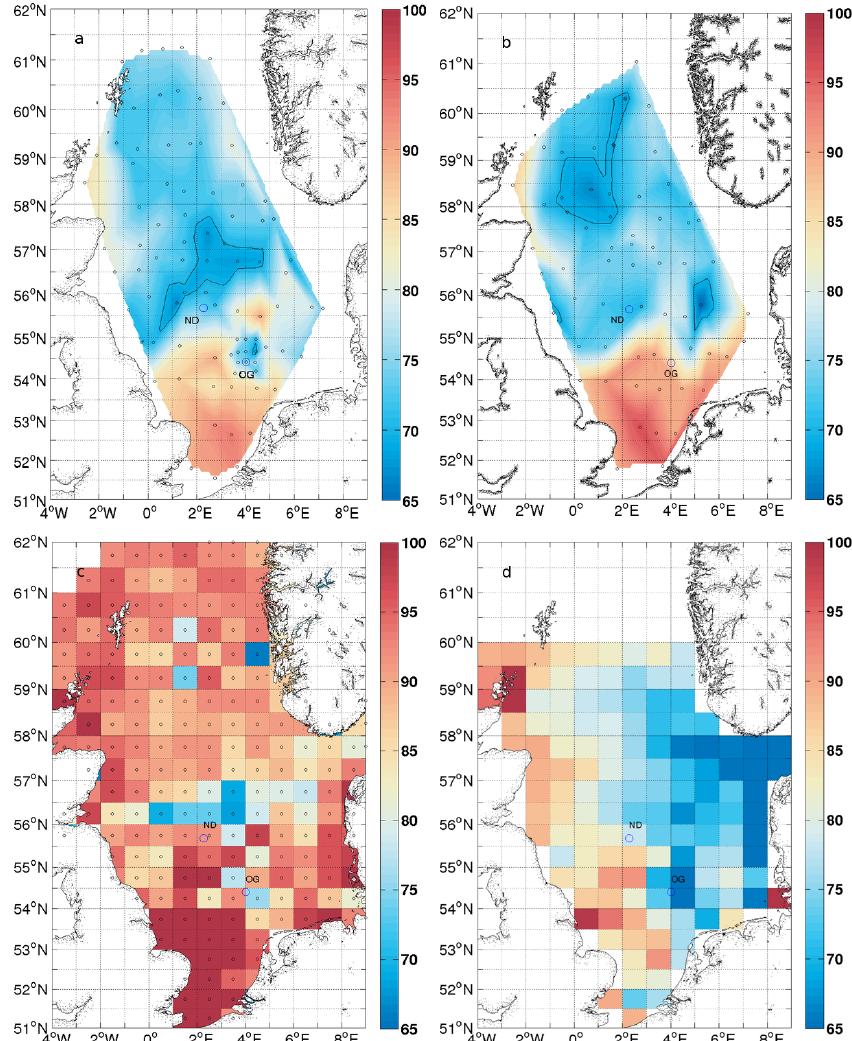
Figure 2. BML oxygen saturation (%) and with the 70% saturation contour during the August 2010 (a) and August 2011 surveys (b) , mean summer bottom oxygen saturation values (%) from 1900 to 2010 from the ICES database (c) , and mean summer bottom oxygen saturation values (%) from 1958 to 2008 from the General Estuarine Transport Model–European Regional Seas Ecosystem Model (GETM-ERSEM) output using European Centre for Medium-Range Weather Forecasts (ECMWF) European Reanalysis (ERA)-interim data (d) .